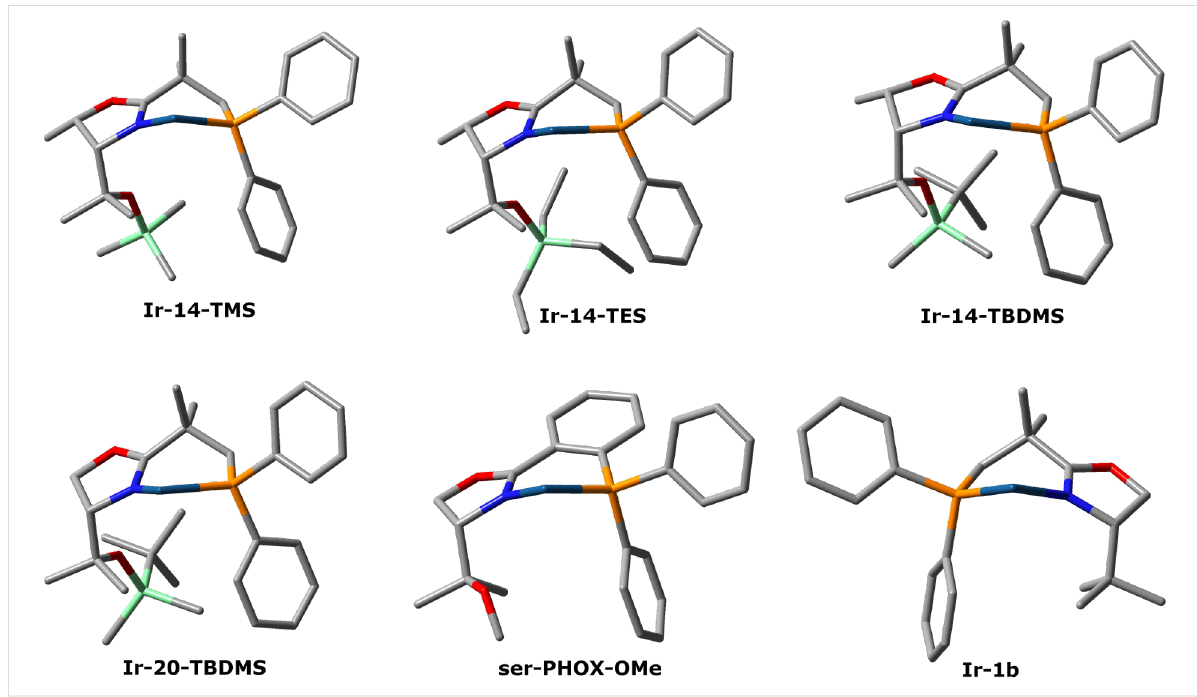
Figure 5: Crystal structures of selected Ir-complexes. Hydrogen atoms, COD and BArF anions were omitted for